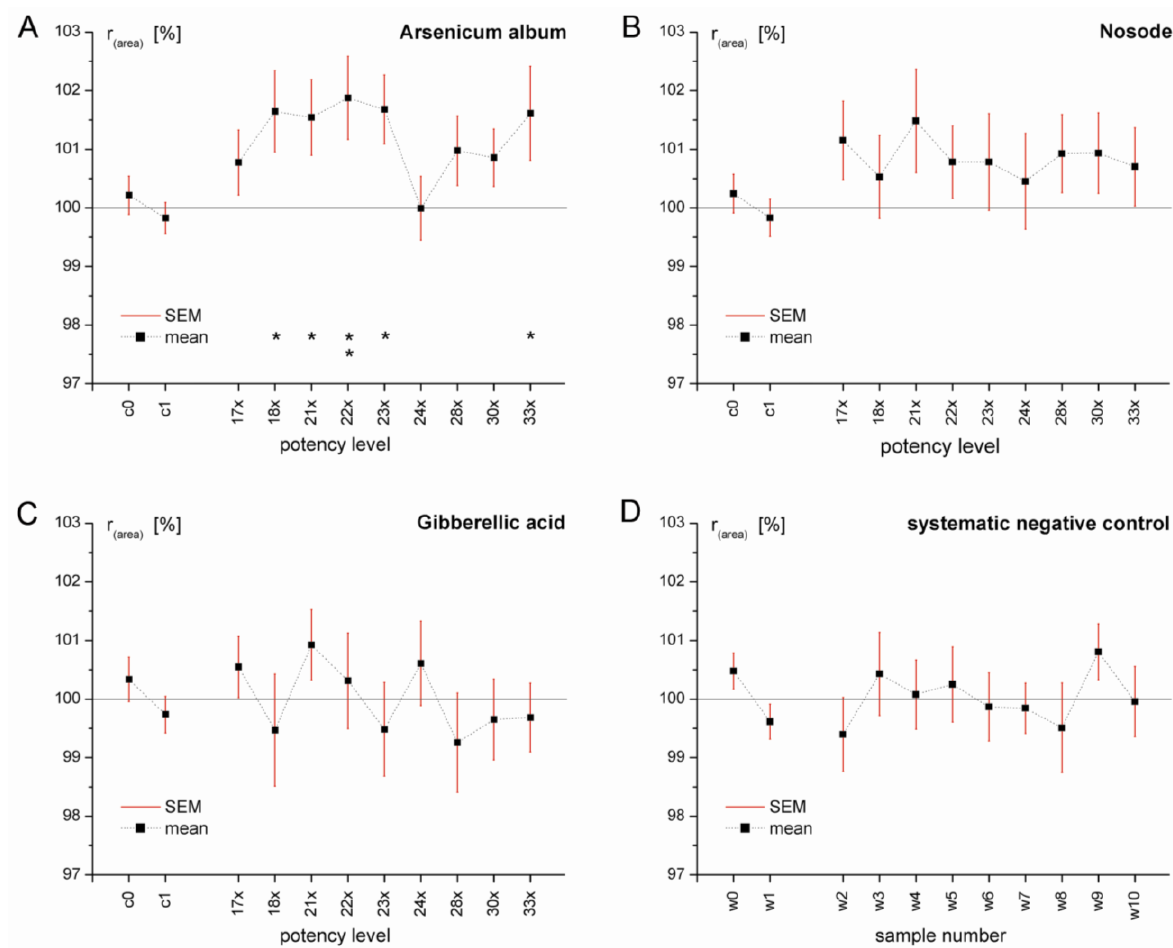
FIGURE 5. Area-related specific growth rates (r (area) days 2–6) [%] of L. gibba growing in different potency levels of selected test substances (A–C) in comparison to the corresponding water controls (c0 + c1). Part (D) shows the corresponding graph for the pure water control experiments (systematic negative controls) with samples of identical origin (unsuccussed water = dilution medium used). Mean values (dots) ± standard error (bars) for five independent experiments, respectively. Every data point for single potency levels is an average from five independent experiments with five replicates (beakers) each (n = 25 per data point plotted). The two data points for controls are an average from five independent experiments with 25 beakers (succussed controls) or 20 beakers (unsuccussed controls) (n = 125 and n = 100 per data point plotted). Data were normalized to the experimental mean of succussed and unsuccussed water controls (c0 + c1) for every individual experiment. Lines connecting data points are no interpolations. Statistically significant differences (Fisher’s LSD test) between single potency levels and the pooled water control c are indicated by *(0.01 < p < 0.05), **( p <